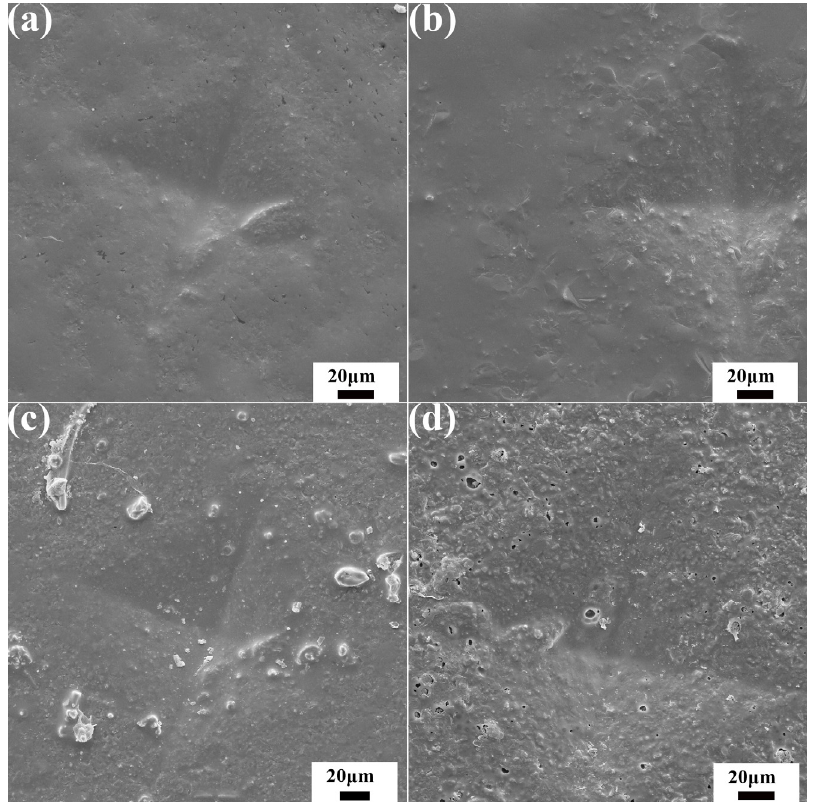
Figure 3. SEM morphology of Vickers indentation and cracks after healing at ( a , b ) 600 °C, ( c , d ) 700 °C and ( e , f ) 800 °C for 60 min.